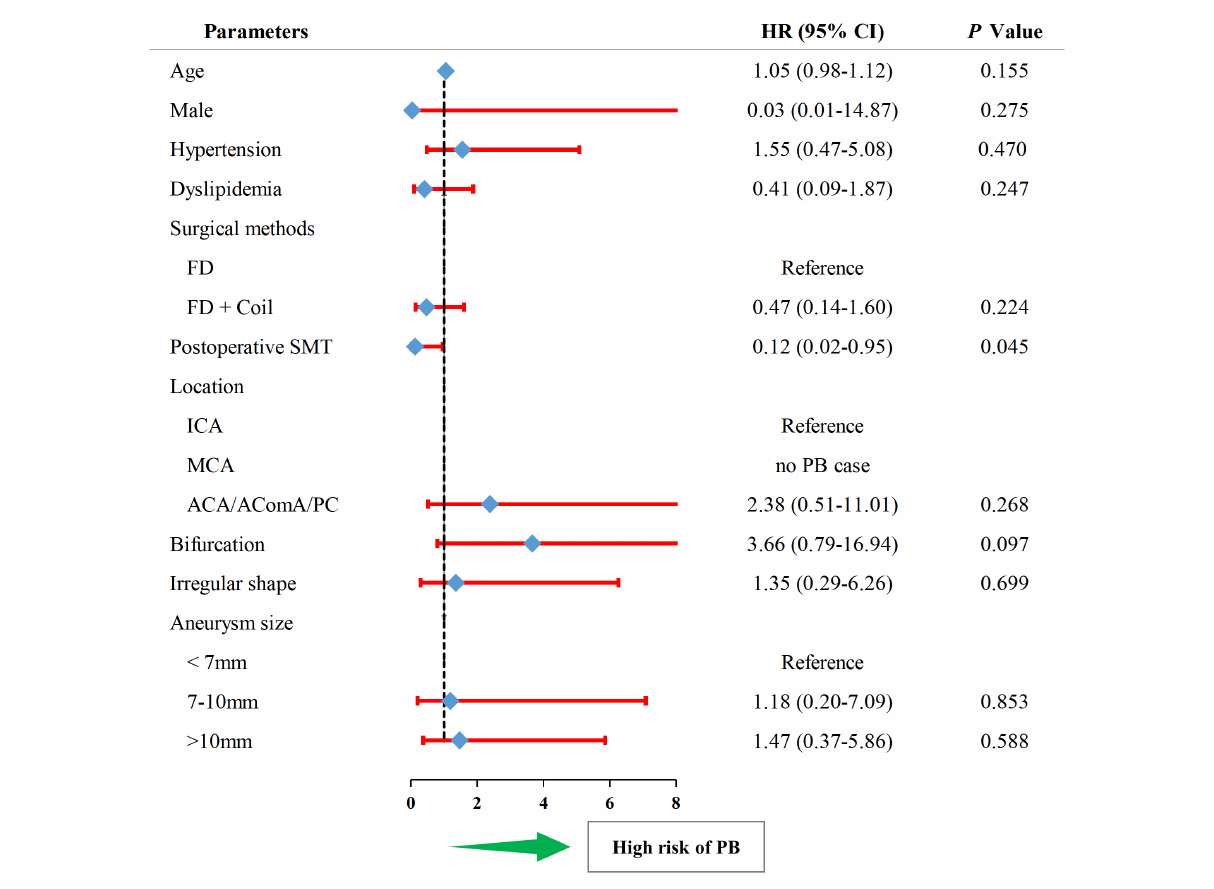
FIGURE 3 The forest plot of univariate Cox regression analysis for risk factors related to postoperative bleeding. HR, hazard ratio; PB, postoperative bleeding; SMT, standard methylprednisolone treatment; ACA, anterior cerebral artery; AComA, anterior communicating artery; PC, posterior circulation; FD, flow diverter.